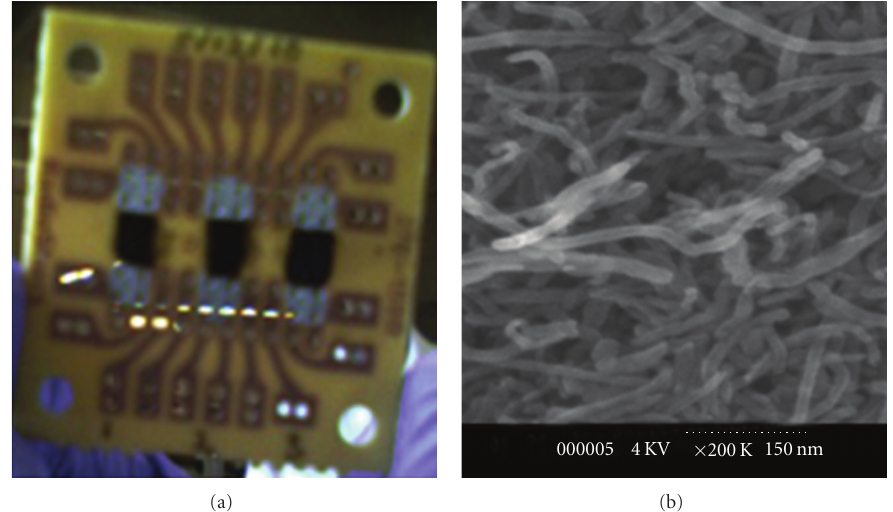
Figure 1: (a) Photographic image of the BNS depicting 3 sensors which are the black spots in the image. (b) SEM-micrograph of the BNS. This micrograph is of the black regions of (a).